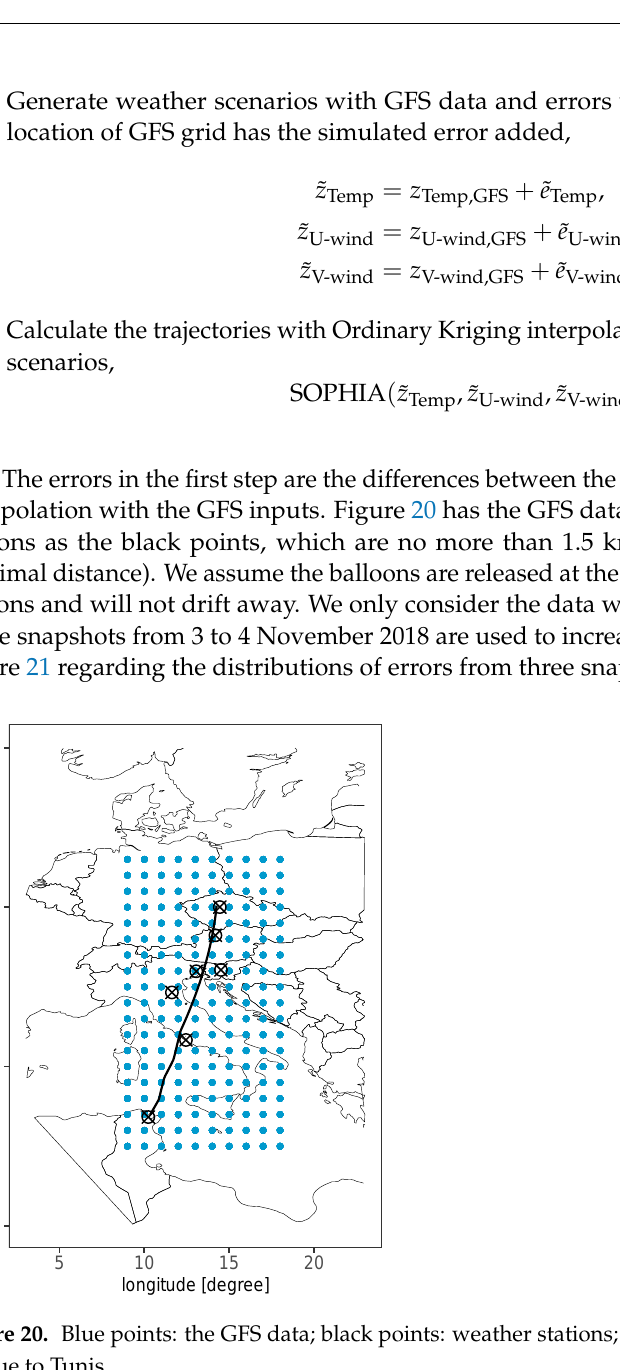
Figure 20. Blue points: the GFS data; black points: weather stations; black curve: the trajectory from Prague to Tunis.